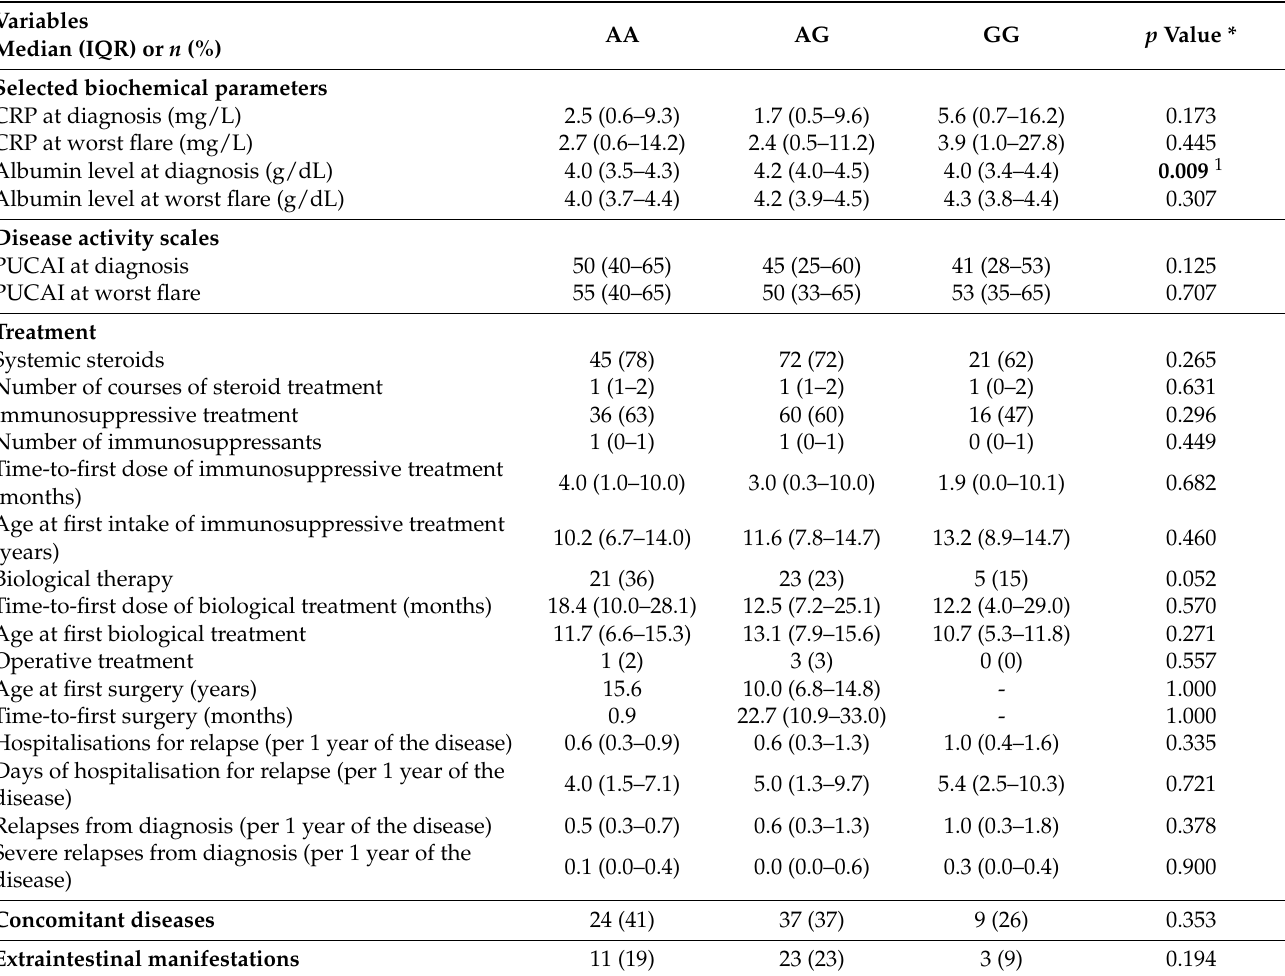
Table 2. Association between DMBT1 rs2981804 genotypes and UC